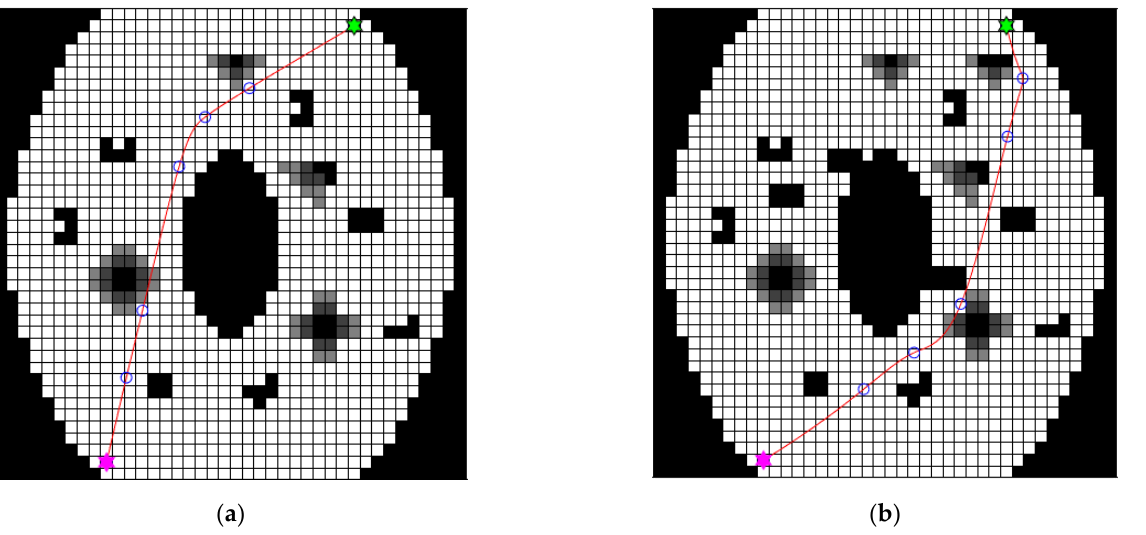
Figure 9. Results of Traditional Genetic Algorithm path planning. ( a ) Simple environment; ( b ) Com- plex environment.